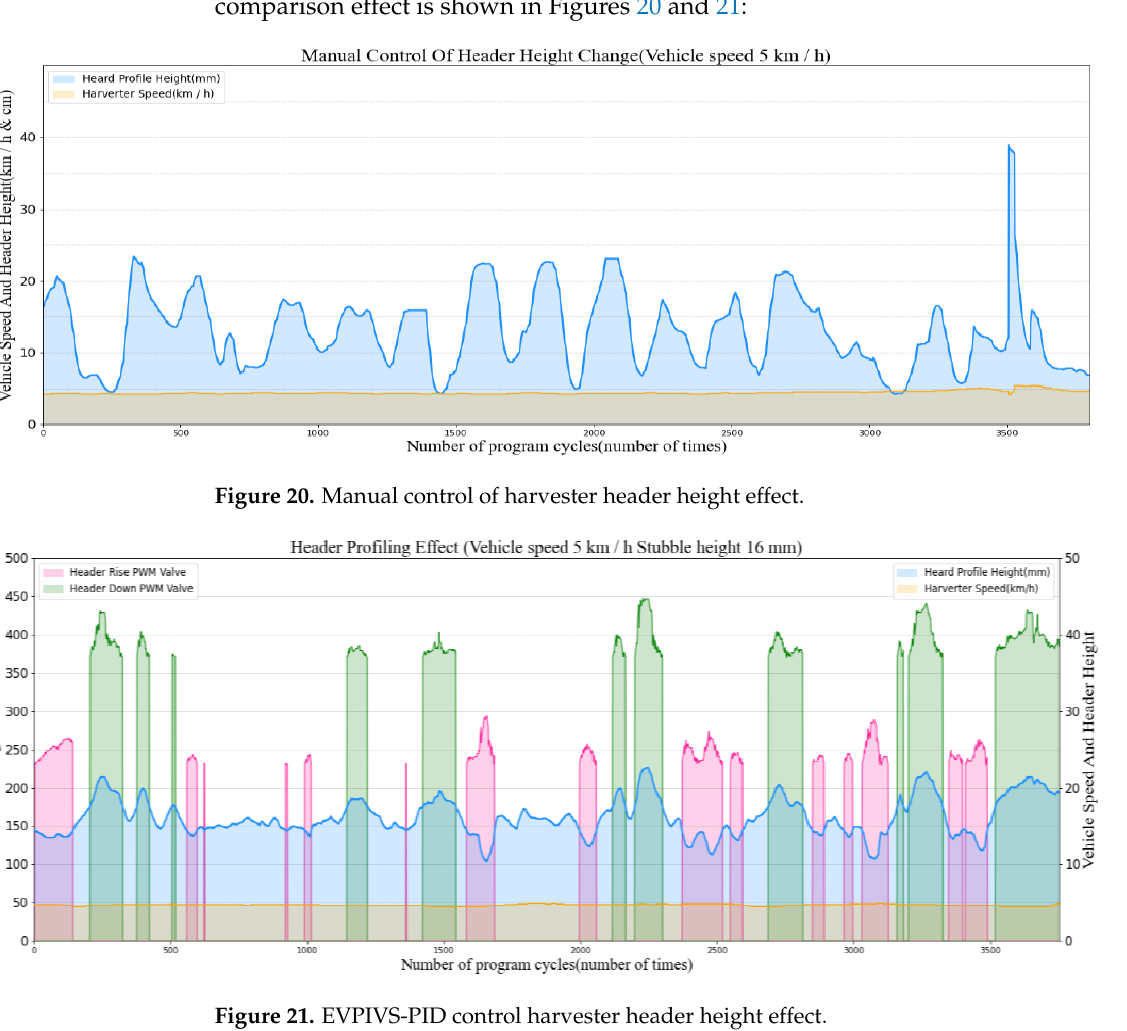
Figure 21. EVPIVS-PID control harvester header height effect.